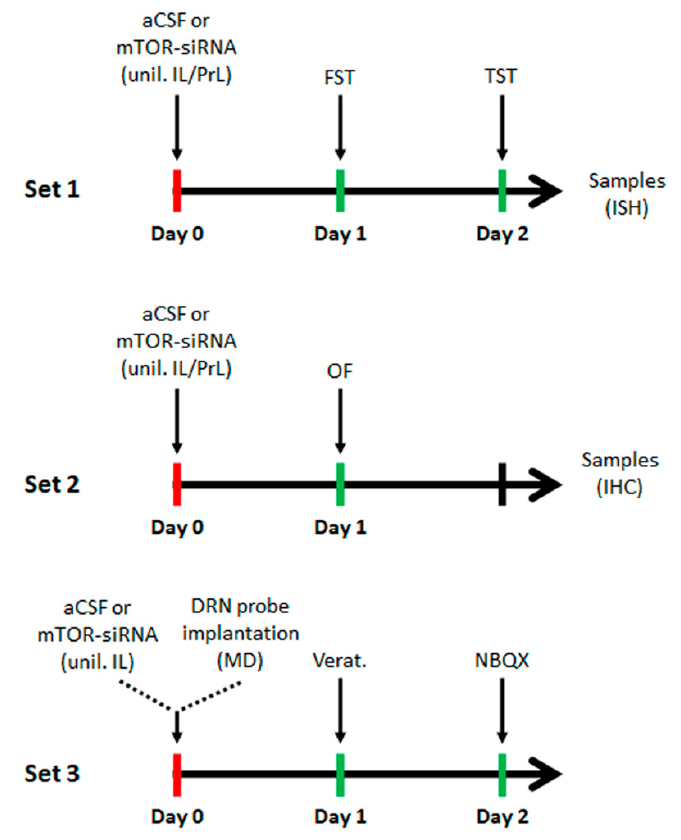
Figure 5 . Experimental schedule of the different experimental procedures performed in this study. mTOR-siRNA or vehicle (aCSF) was unilaterally infused in the IL or PrL cortices for the behavioral experiments (sets 1 and 2), and in the IL cortex for the microdialysis studies (set 3). Samples were collected 48 h post-infusion (2 h after the last behavioral test for set 1). aCSF: artificial cerebrospinal fluid; siRNA: small interfering RNA; unil.: unilateral infusion; IL: infralimbic cortex; PrL: prelim- bic cortex; DRN: dorsal raphe nucleus; FST: forced swimming test; TST: tail suspension test; OF: open-field test; ISH: in situ hybridization; IHC: immunohistochemistry; MD: microdialysis; Verat.: vetridine; NBQX: